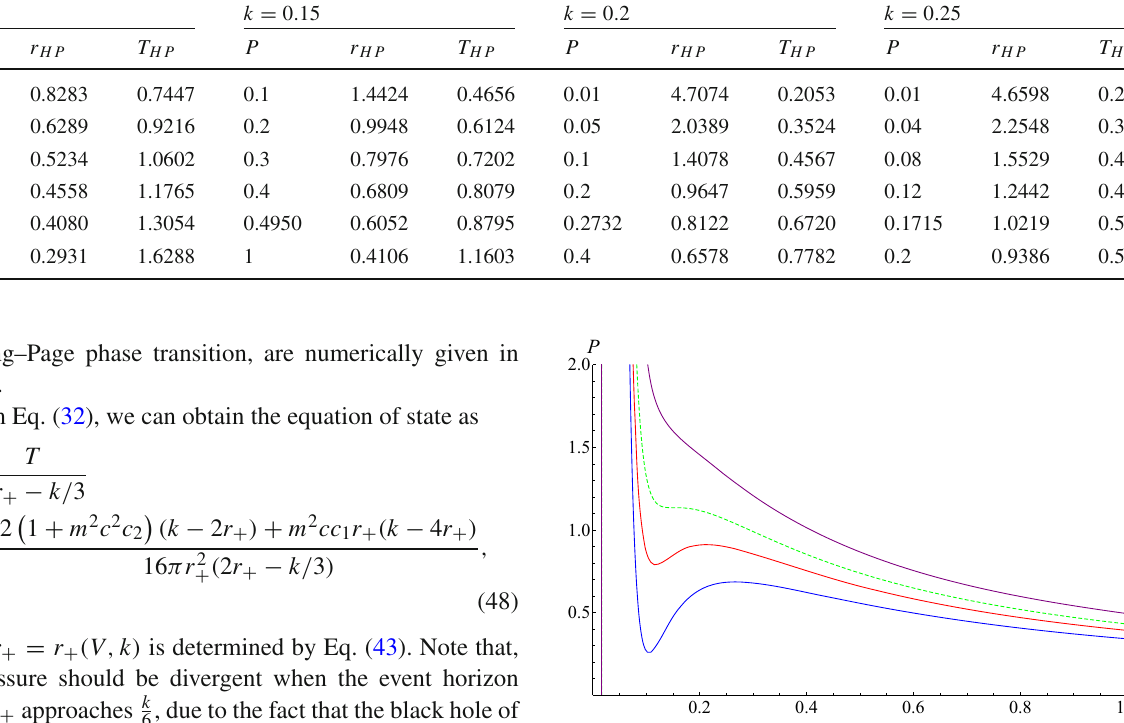
Table 1 The numerical results for the radius r HP and the temperature T HP at the Hawking–Page phase transition, for the different values of the characteristic parameter k of the non-linear electrodynamics and the pressure, at m = c = c 1 = c 2 = 1 k = 0 . 1